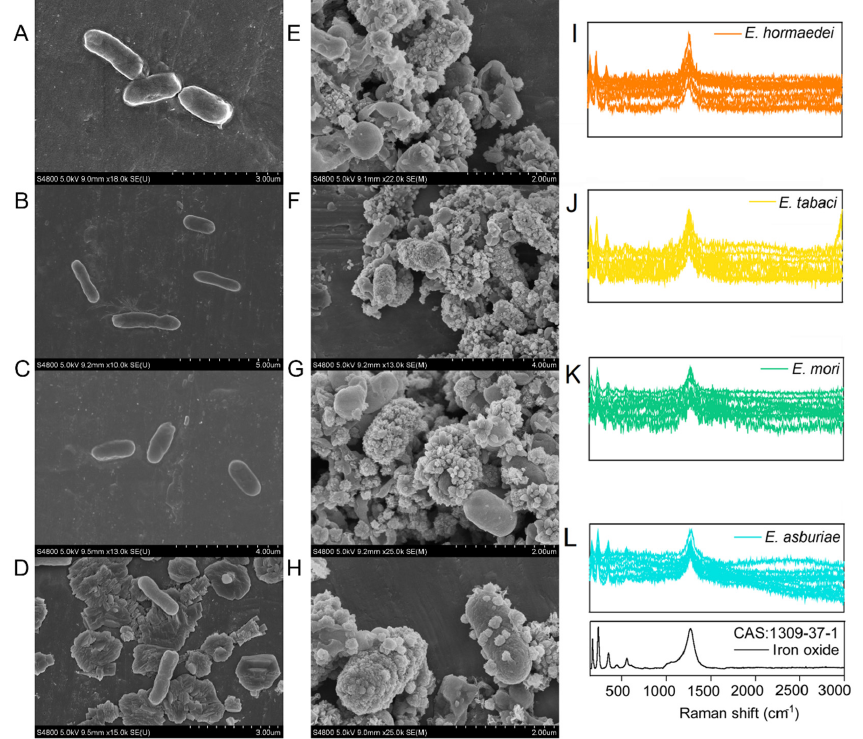
Figure 3. Morphological characteristics of Enterobacter strains in the LB ( A – D ) and NRFO ( E – H ) medium and iron(III) oxides ( I – L ) in the surface of the corresponding cells using Raman microspec- troscopy.